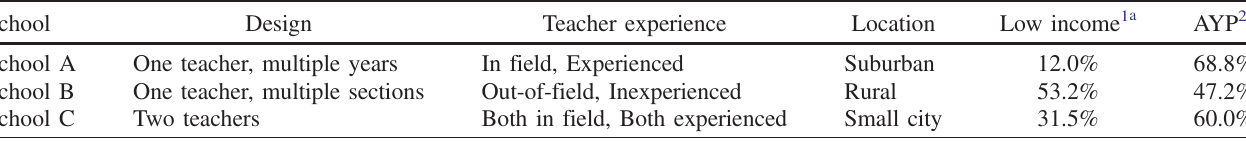
TABLE I. Profile for each high school participating in the